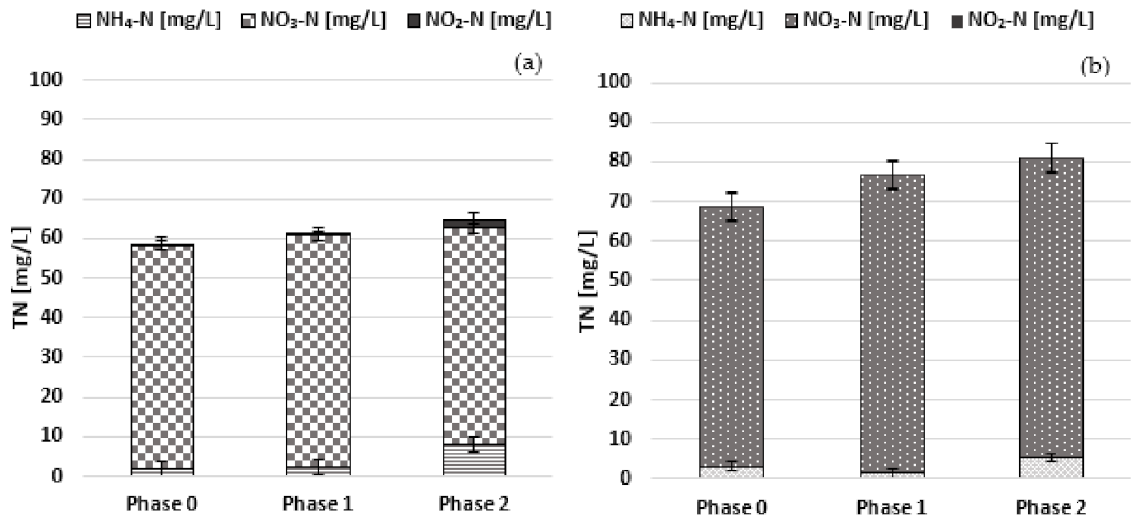
Figure 4. Overview of the NH 4 -N, NO 2 -N, and NO 3 -N concentrations over the entire experiment in the BR 1-1 ( a ) and BR 2-1 ( b